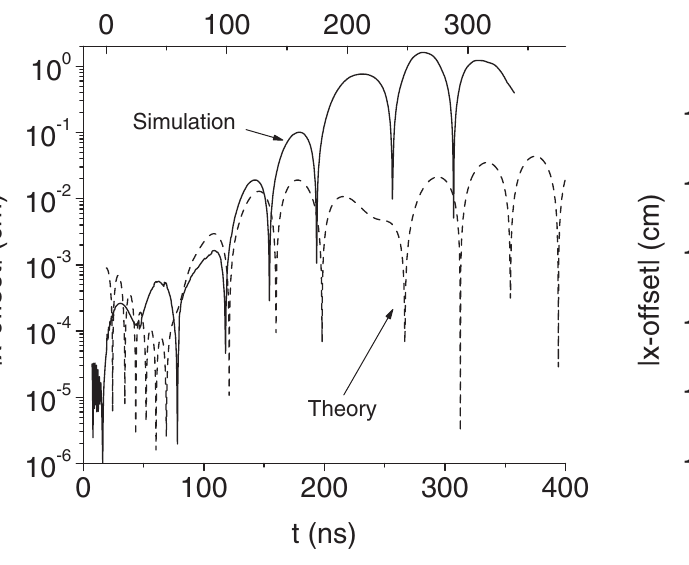
(cid:6) 4 cm . FIG. 10. Comparison of the model predictions (dashed line) 0